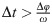
The solution of the system (20) and (21) at times t = 0.25, 0.5, 1, 20 for parameters ω = 1, γ = 2, φ0 = 3π/4.We have used an upwind method that replaces the spatial derivatives of u and v using a backward and forward finite differences, respectively and the temporal derivative by a forward difference. This method is stable for Δt>Δφω that we ensure by choosing Δt=2Δφω.